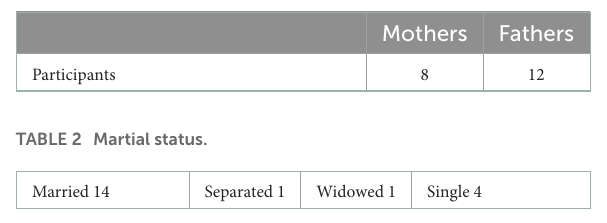
TABLE 1 Number of mothers and fathers in the latest round of interviews.